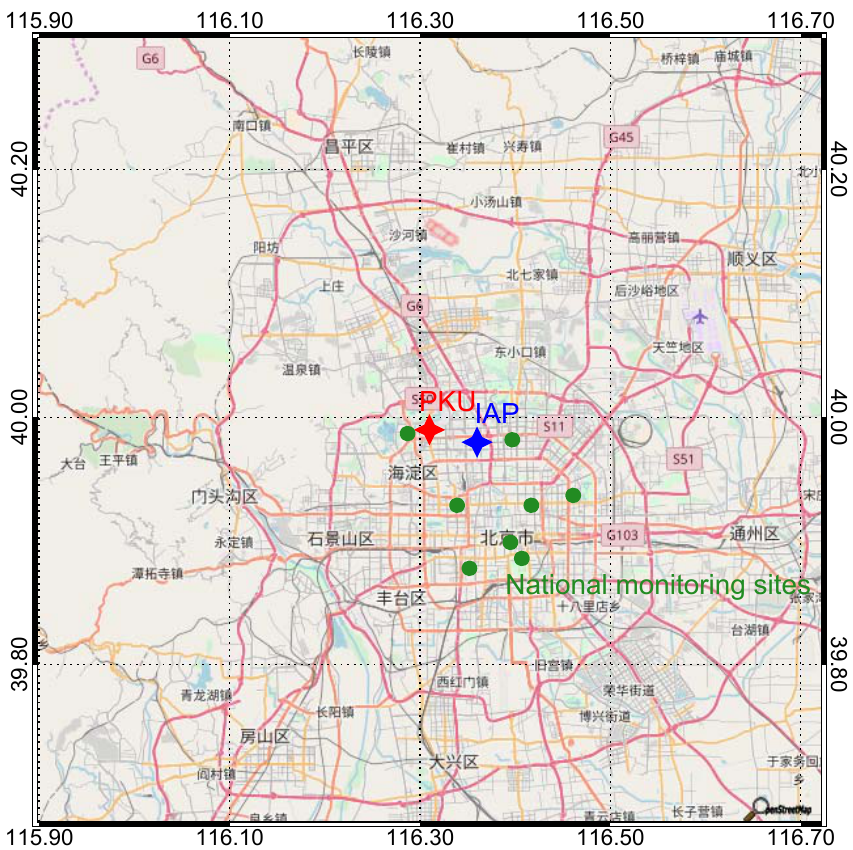
Figure 1. Location of the monitoring sites used in this study, including PKU (red diamond), IAP (blue diamond), and other national moni- toring sites (green circles). Vertical profiles of NO x and O 3 were collected at a tower at the IAP. Measurements of particle number and size distribution (used to calculate N 2 O 5 and particle nitrate formation) were collected from a ground site at PKU. Additional measurements of PM 2 . 5 concentrations were continuously taken at national monitoring sites throughout